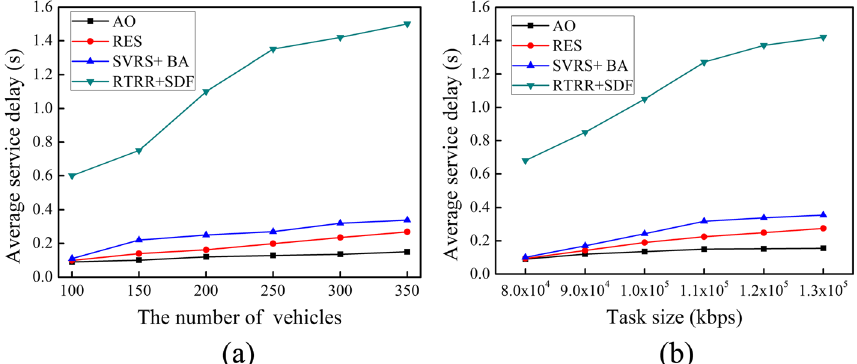
Fig. 3 Impact of service delay time. a w.r.t. The number of vehicles b w.r.t. Task